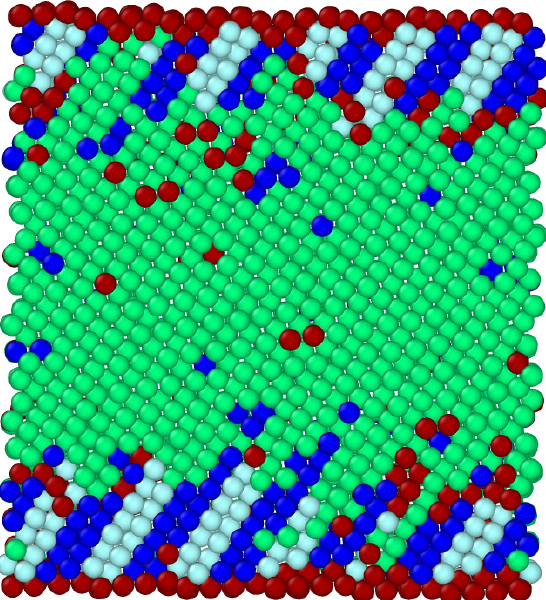
Figure 6. Side view of the thin film with a (7 1 0) bcc surface at the beginning of the austenitic transformation, highlighting the nucleation of the close-packed phases at the top surface. Colors denote the local lattice structure as in Figure